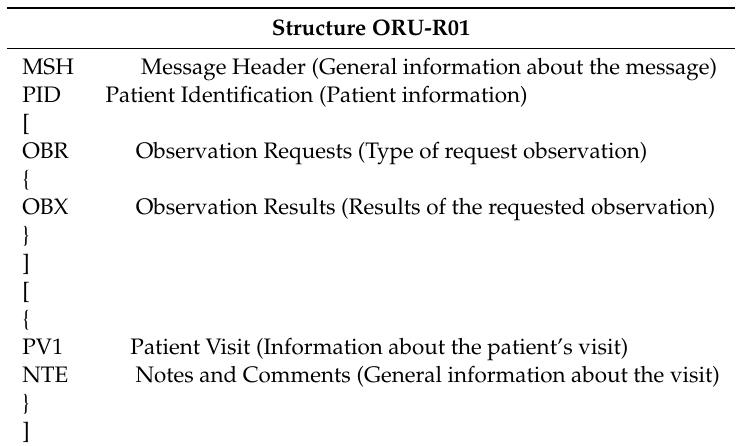
Table A1. Message